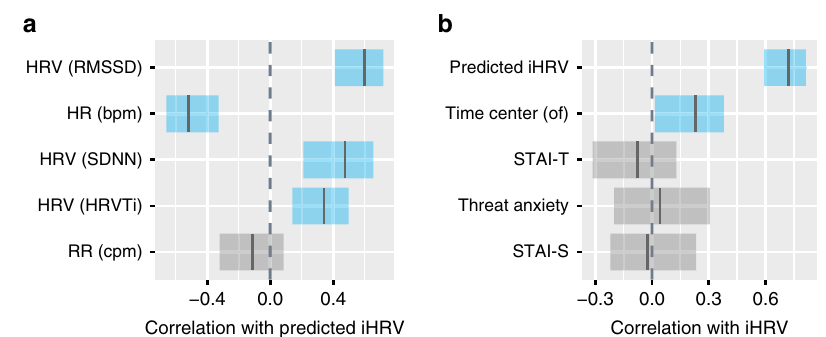
Fig. 3 Correlation plots. a Correlation between the model ’ s prediction of PC1 (i.e., iHRV) for the entire data set with each of the cardiorespiratory variables used to create PC1. b Comparison between PC1 and the model ’ s prediction and the correlation between PC1 and other possible explanatory variables. Time center (er) — time in the center of the empty room; STAI-T - self-reported trait anxiety; Threat anxiety — self-reported anxiety felt during the persistent threat scenario; STAI-S — self-reported state anxiety. Black line in the center of shaded area are Pearson correlation coef fi cients; shaded area, 95% con fi dence intervals for the correlation coef fi cients, corrected for multiple comparisons in each panel; blue shaded area, signi fi cant correlation corrected for multiple comparisons in